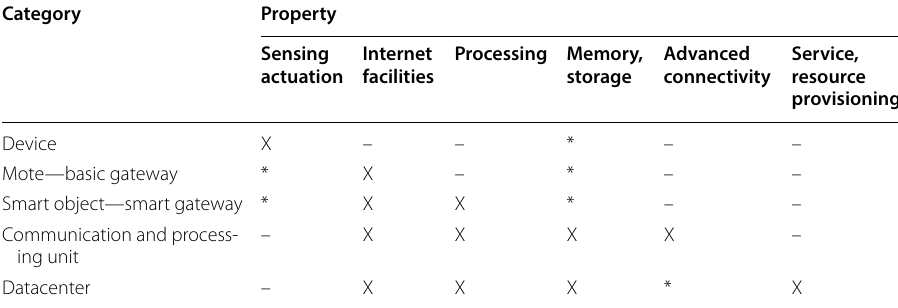
Table 1 IoT resources categorisation